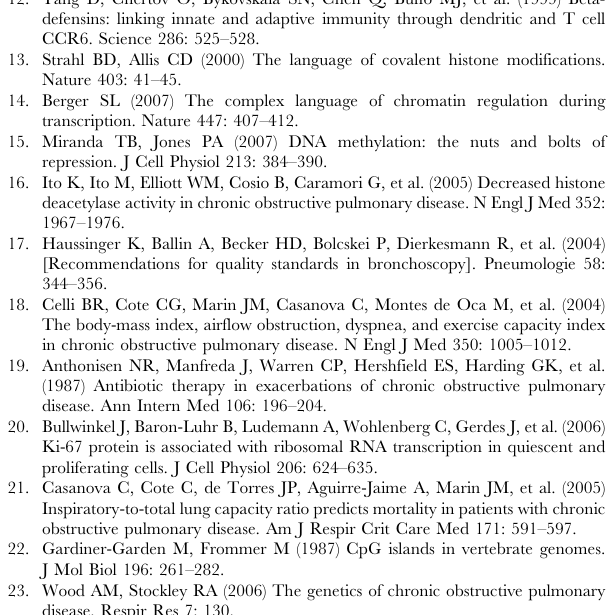
Table S1 Detailed characteristics of the study partici- pants (additional to Table 1). Data are presented